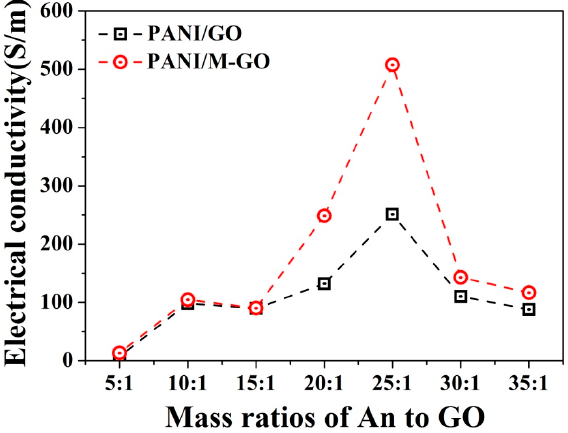
Figure 2. Electrical conductivities of PANI/GO composites as a function of microwave pretreatment of graphite and different feeding ratios.